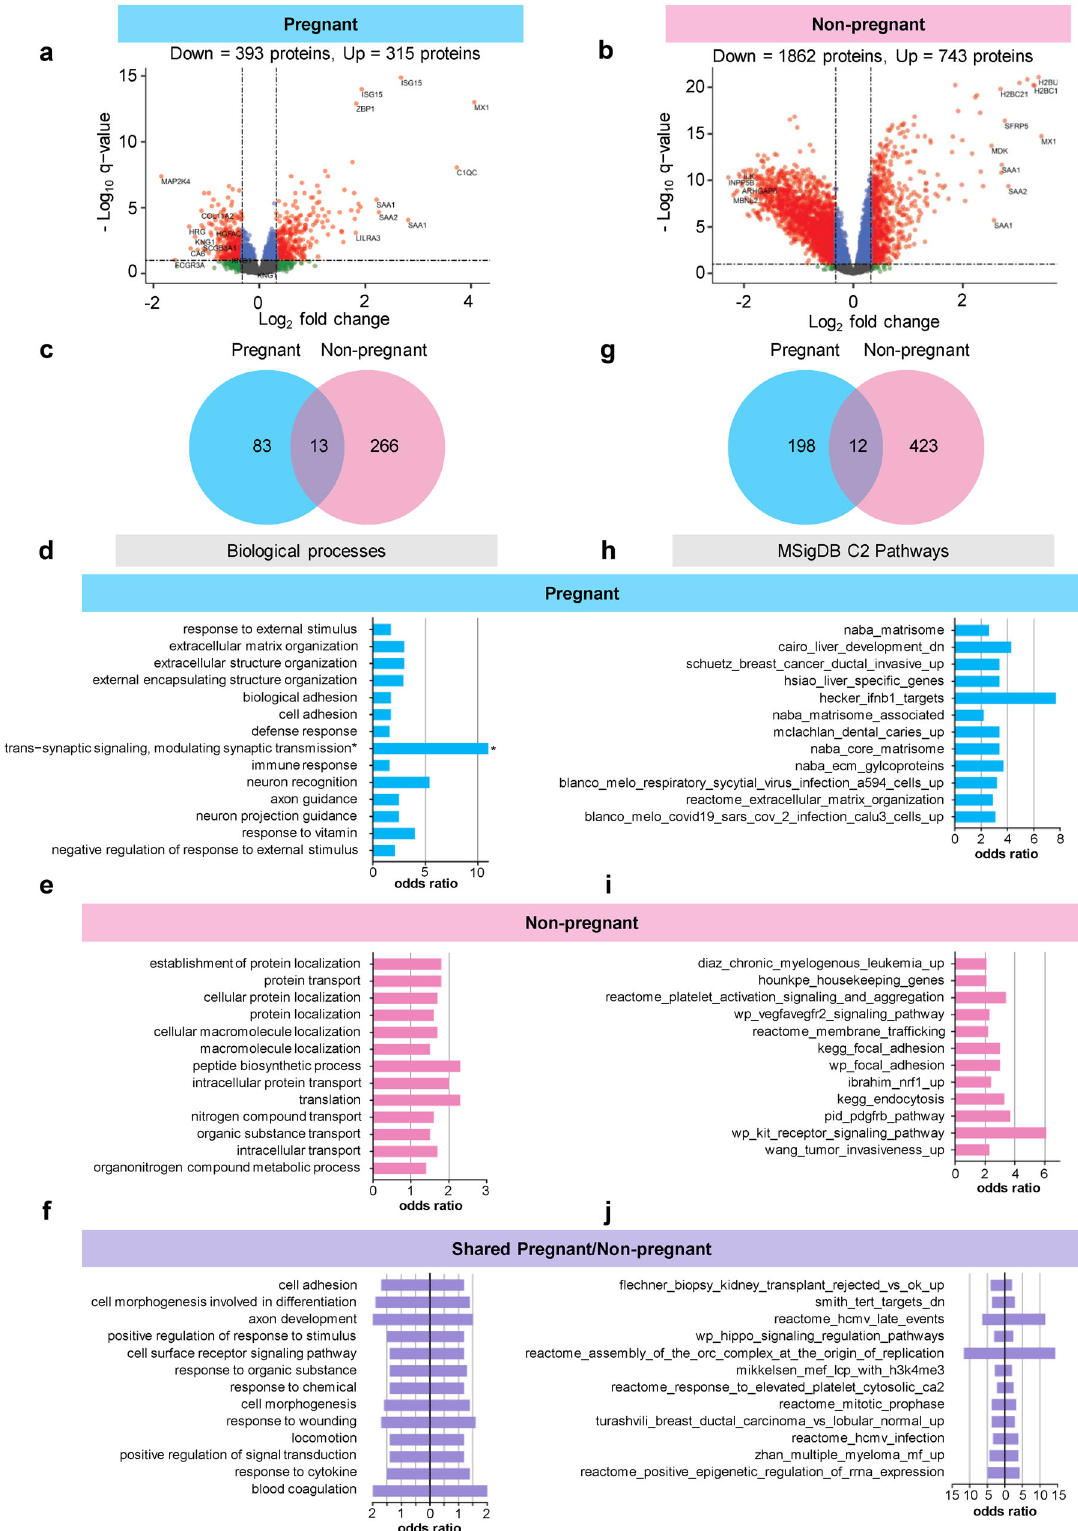
The plasma proteome can discriminate COVID-19 cases from uninfected controls, even when mild or asymptomatic . Last, we evaluated the ability of the proteomic pro fi les to discriminate between COVID-19 cases and controls, regardless of pregnancy status. For this purpose, we developed random forest models that included up to 50 proteins and evaluated their accuracy via leave-